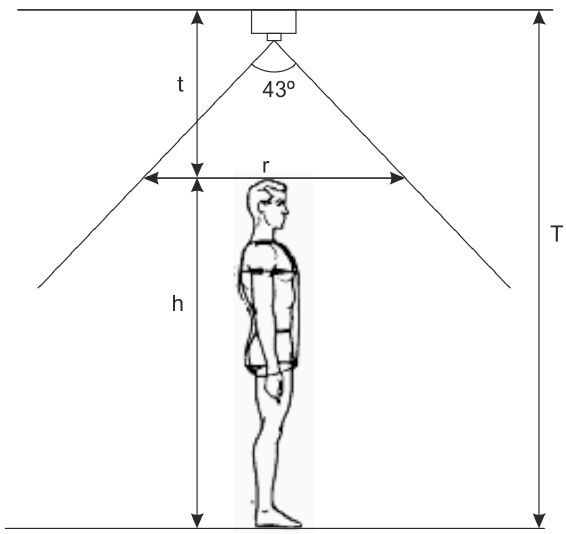
Figure 1. Kinect setup